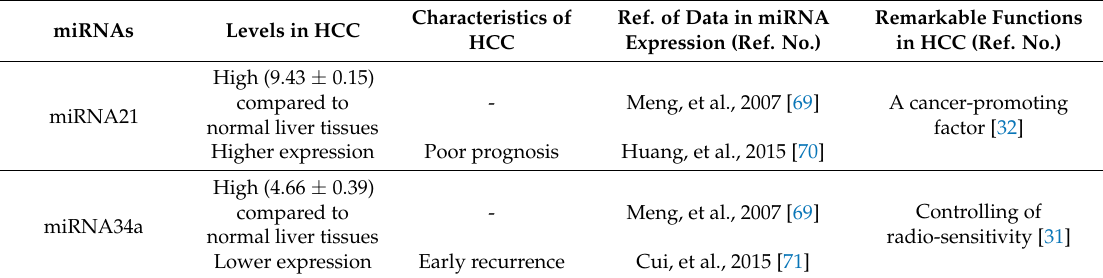
Table 2. Levels and functions of miRNAs in human hepatocellular carcinomas. Characteristics of Ref. of Data in miRNA Remarkable Functions miRNAs Levels in HCC HCC Expression (Ref. No.) in HCC (Ref. No.) High (9.43 ± 0.15) - Meng, et al., 2007 [69] A cancer-promoting compared to miRNA21 normal liver tissues factor [32] Higher expression Poor prognosis Huang, et al., 2015 [70] High (4.66 ± 0.39) - Meng, et al., 2007 [69] Controlling of compared to miRNA34a radio-sensitivity [31] normal liver tissues Lower expression Early recurrence Cui, et al., 2015